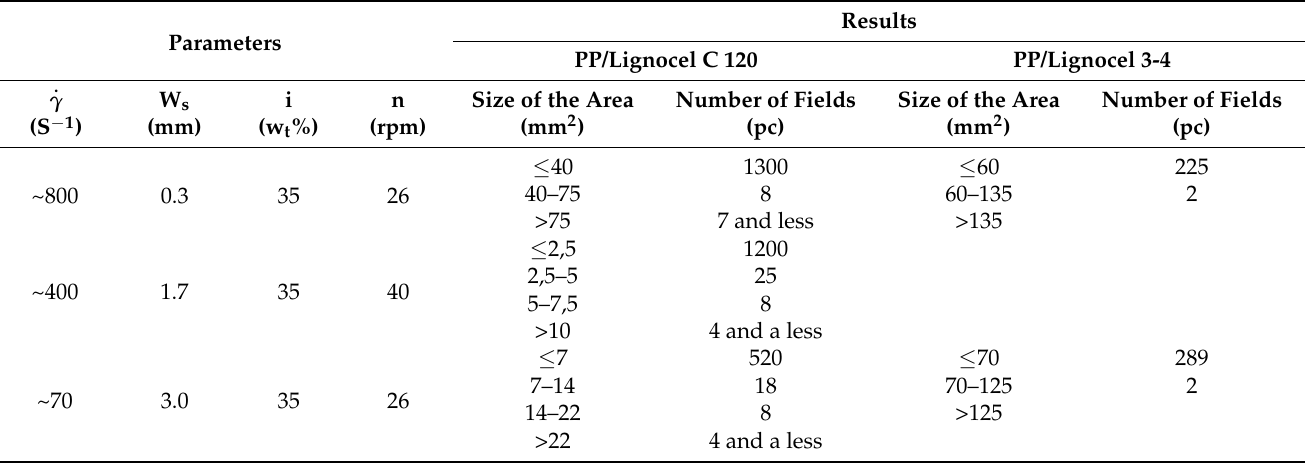
Table 4. Results of the analysis of WPC composite images for different values of shear rate.